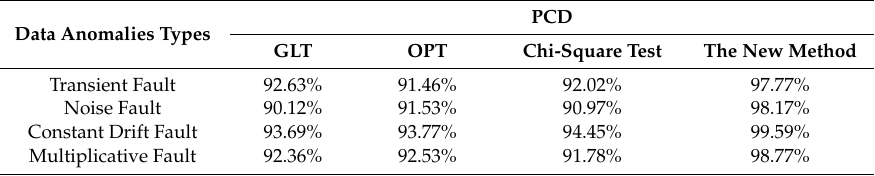
Table 9. Statistics of diagnostic results of di ff erent methods after outliers